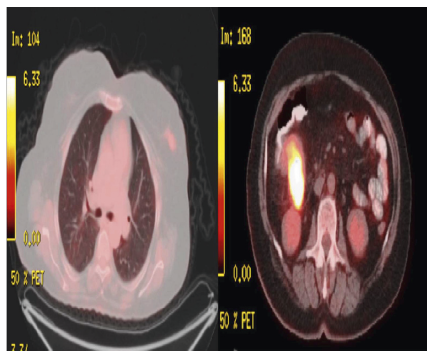
Figure 2: PET-CT showing increased FDG uptake.